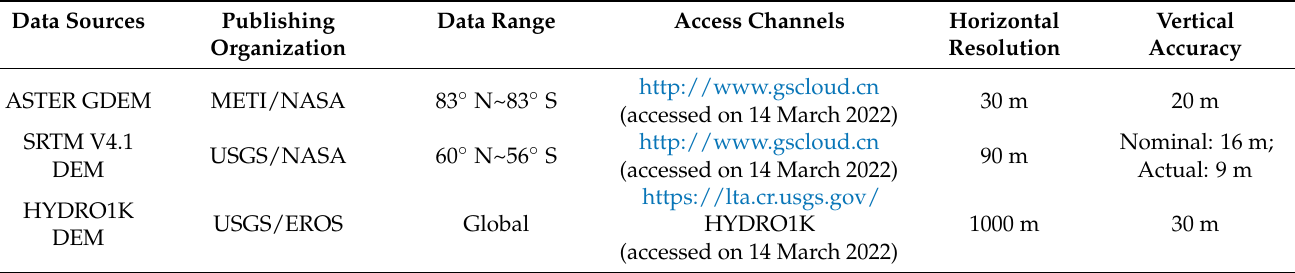
Table 1. Introduction of DEM data